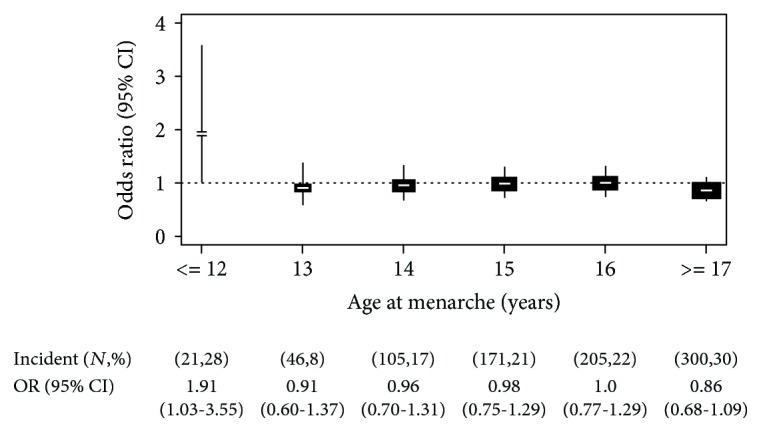
Risk of MetS in each age of menarche. Odds ratio (OR) and 95% confidence interval (CI) of Mets by each age at menarche. N is the number of incidence in each age of menarche; % is the percent of incidence in each age of menarche. The size of rectangle represents the number of samples. The vertical line indicates the overall OR on each age of menarche. ORs were adjusted for area, age, income, education, and C-reactive protein levels. The reference category was menarche at 16 years of age.